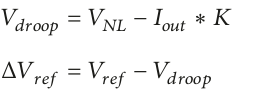
Figure 9: Load regulation characteristic of the droop method with gain of 𝐾